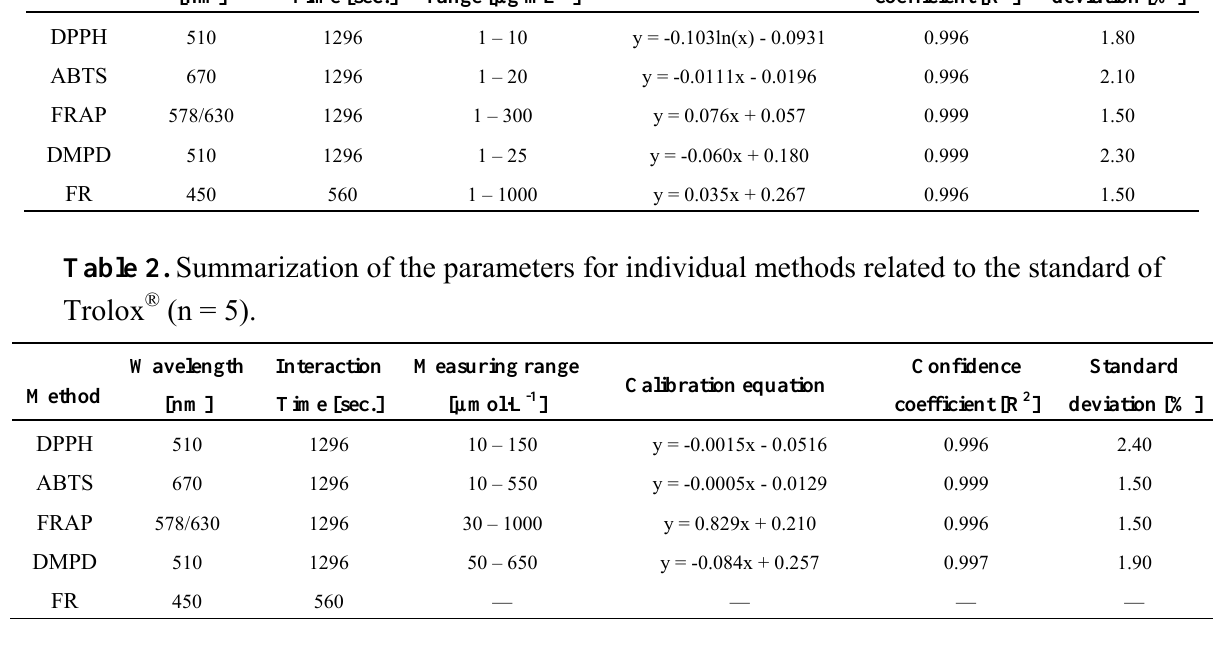
Table 3. Summarization of the parameters for individual methods related to standard of δ - tocopherol (n =